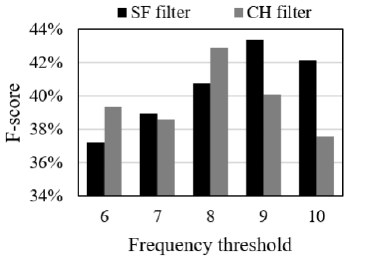
Figure 6. F-score comparison between the SF and CH filters